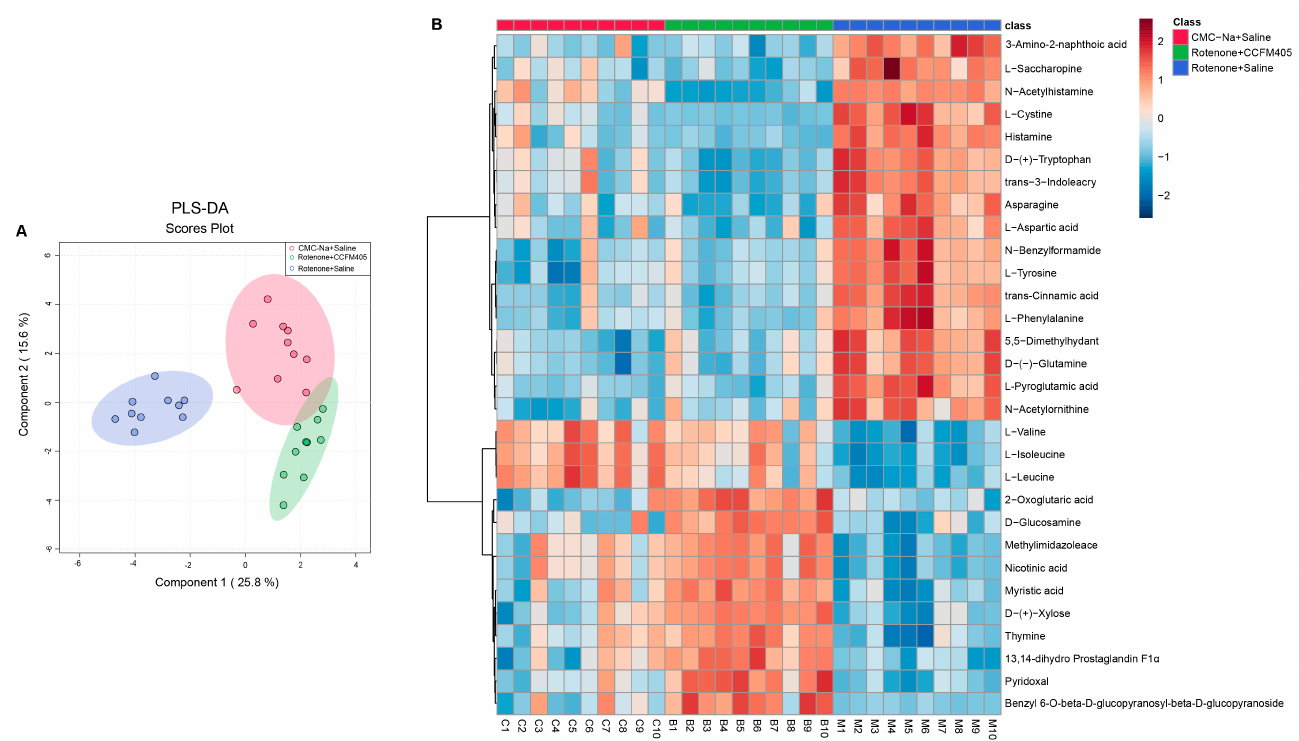
Figure 9. The PLS-DA model was utilized to analyze the compositions of fecal metabolites in each group of mice. ( A ) Two-dimensional score plot of PLS-DA of fecal metabolites among three groups; ( B ) cluster heat map of the top 30 differential metabolites ranked significant by one-way ANOVA for fecal metabolites among three groups, n = 10/group.